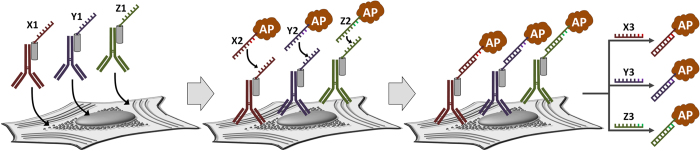
Schematic illustration of the multiplexed in-cell immunoassay.The specimen is first incubated with a library of self-assembled 1′Ab/PrA-ssDNA probes and then with a cocktail of complementary ssDNA′-functionalized reporters (e.g., an enzyme alkaline phosphatase, AP). Target labeling occurs through (i) antibody-antigen binding and (ii) ssDNA-ssDNA′ hybridization. As a result, all targets of interest are simultaneously labeled by the same reporter, but each target is linked to a reporter via a displaceable DNA bridge with a unique sequence (e.g., X1-X2, Y1-Y2, or Z1-Z2). This enables the release of subsets of target-bound reporters into solution via sequence-specific DNA bond displacement with a longer complementary ssDNA probe (X3, Y3, or Z3, respectively), yielding unbound reporter concentration equivalent to the corresponding target abundance in the specimen. Multiplexed same-sample protein expression profiling is achieved by quick sequential release and segregation of all target-bound reporters one-by-one (e.g., into separate wells of a 96-well plate for high-throughput quantitative analysis with a plate reader).